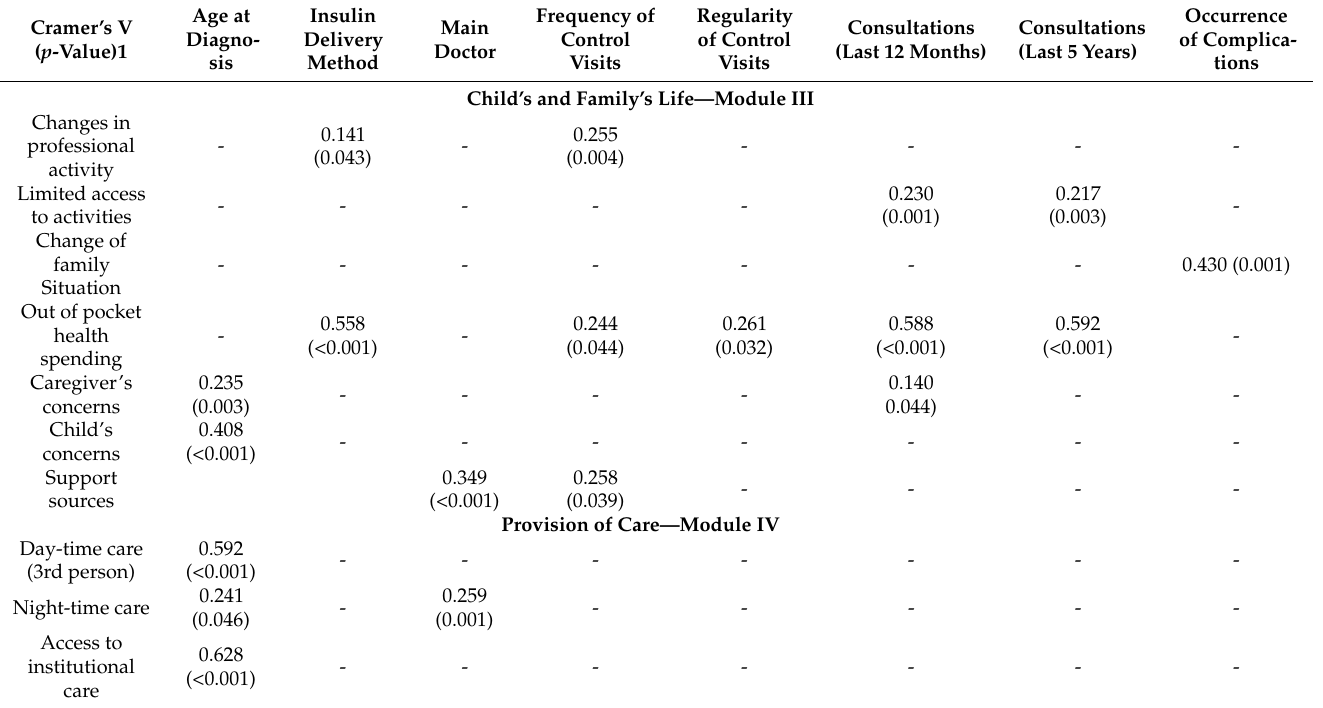
Table 4. Influence of health